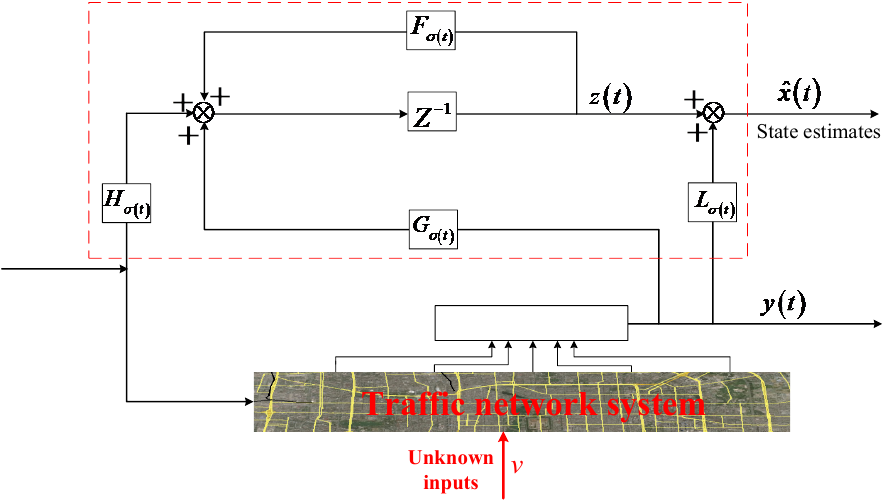
Figure 2. The structure of the reduced-order unknown-input state observer.